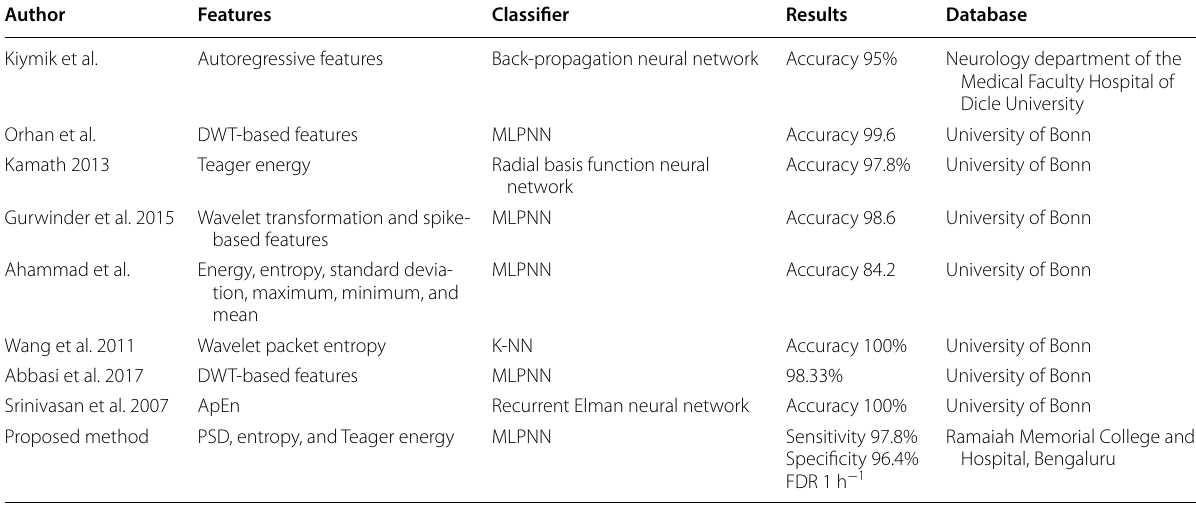
Table 5 Comparison results of some epileptic seizure detection